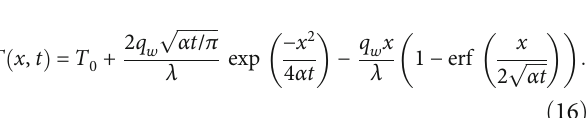
Figure 7: The regression rate obtained from the experiment and the simulation for the SFRJ